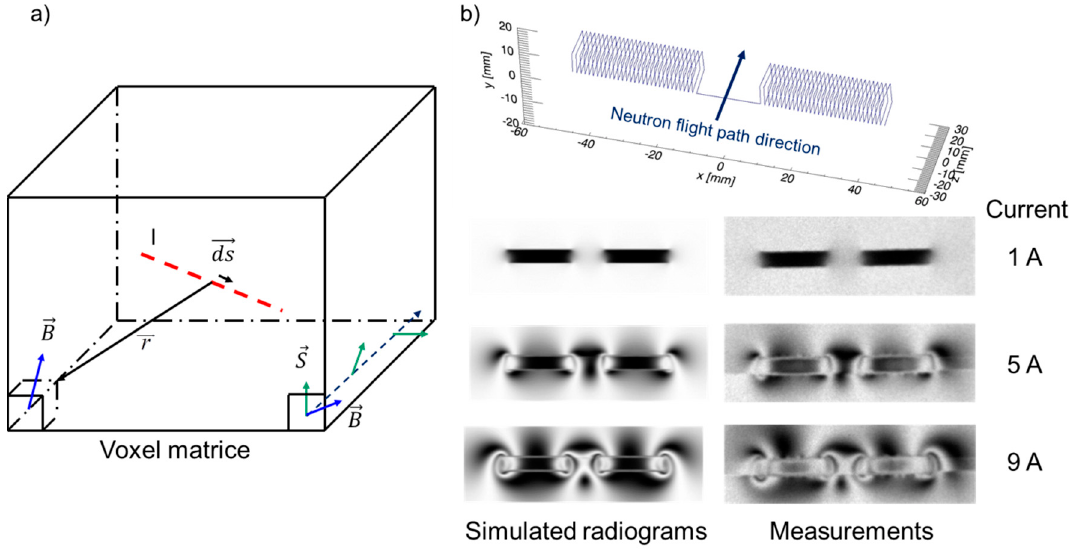
Figure 4. ( a ) Example for space discretization used in simulations of imaging with polarized neutrons. ( b ) Measurements and simulations of spin-precession image of rectangular double coil measured at different current values [3].